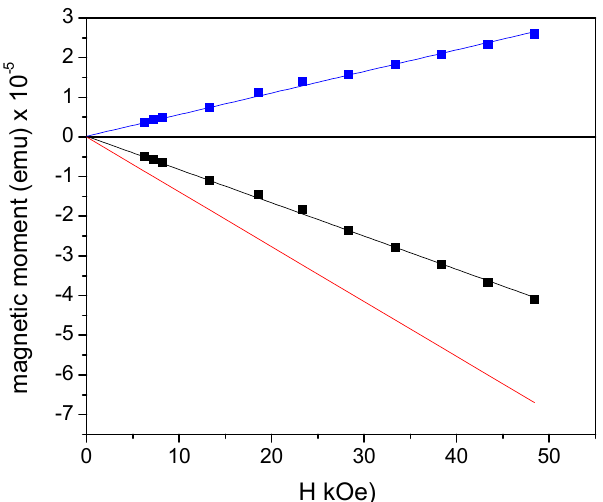
Figure 7. Magnetic moment measured as a function of H, at T = 300 K, on empty (red line) and MDB-loaded LS (black line). The blue line is the magnetic response of the sole MDB. The produced liposomal samples were subjected to a basic relaxometric investigation.